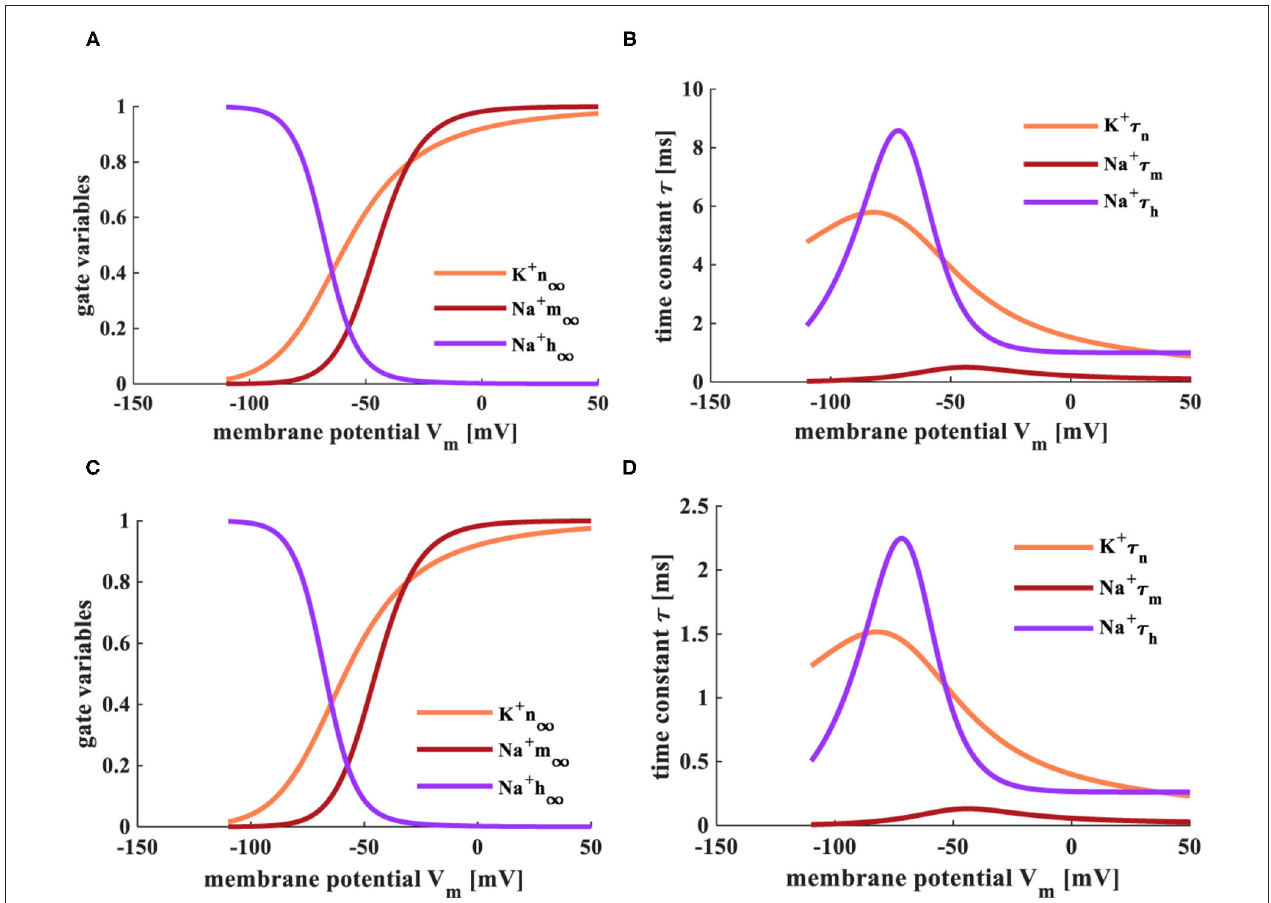
FIGURE 3 | The relationship between gate-controlled variables, the time constant, and the membrane potential. (A) The evolution of the gate-controlled variables (m, n, and h) at the temperature of 6.3 ◦ C . (B) The change of the time constant ( τ ) at the temperature of 6.3 ◦ C . (C) The change of the gate-controlled variables (m, n, and h) at the temperature of 18.5 ◦ C . (D) The evolution of the time constant ( τ ) at the temperature of 18.5 ◦ C